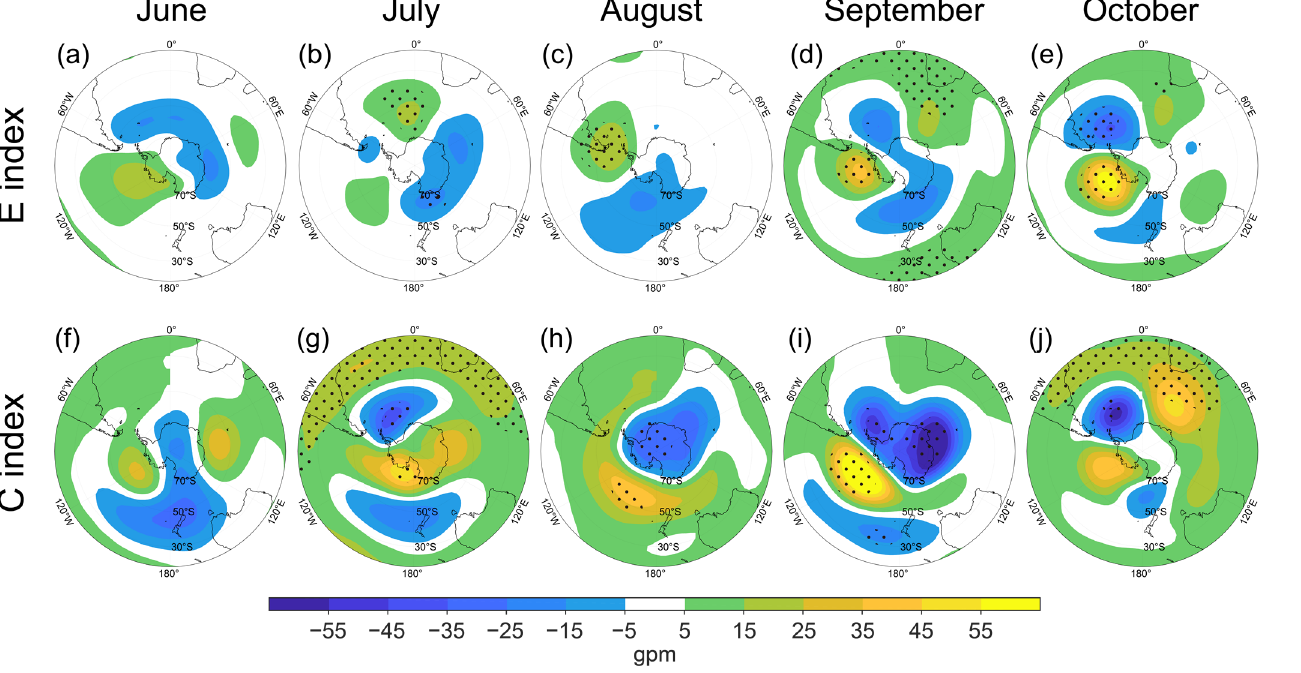
Figure 10. Regression of geopotential height anomalies at 70 hPa onto ( a – e ) E index and ( f – j ) C + index from June to October. Dotted areas represent statistically significant values at a 90% confidence level. Contour interval is 20 gpm. The outermost latitude is 20° S.